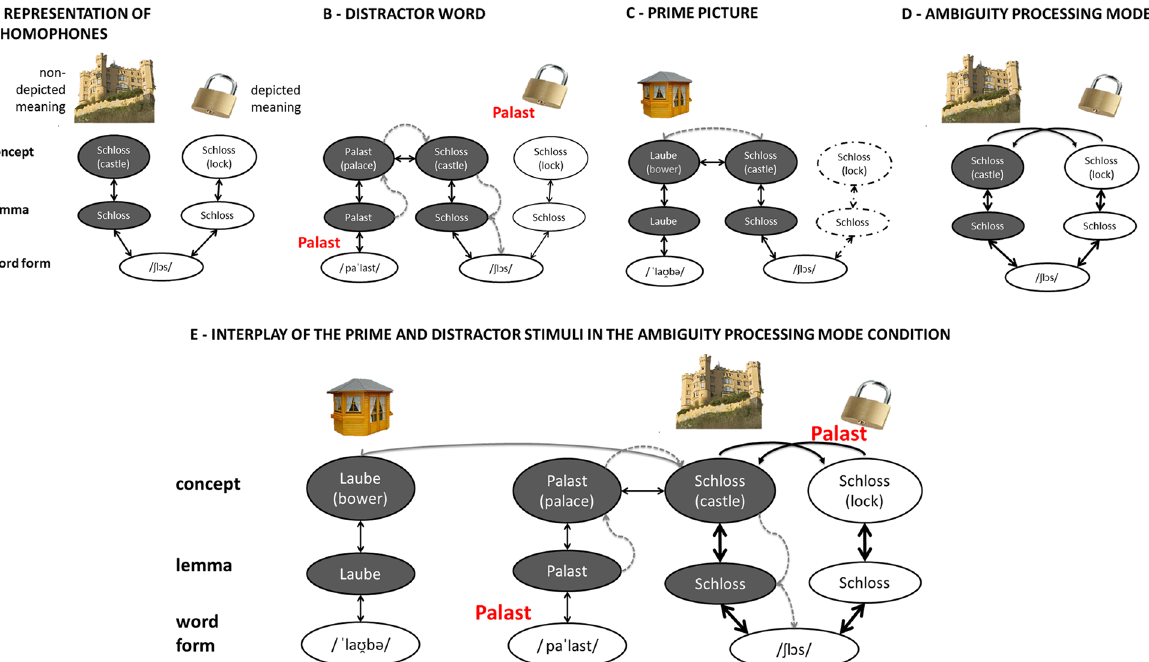
Fig 1. Models explaining effects of prime relatedness, distractor relatedness and ambiguity processing mode on naming of pictures with homophone names. (A) Representation of homophones: homophones have different conceptual and lexical representations but share the same word form. (B) Cascading information flow of distractor words related to the non-depicted meaning of the homophone and pre-activation of the shared word form. (C) Pre-activation of the non-depicted meaning by a previously presented prime stimulus that is categorically related to the non-depicted meaning of the target ‘ s name. (D) Listening to puns leads to the co-activation of both meanings of a homophone due to enhanced feedback between phonological, lexical and semantic stages and thus the ambiguity status of a target ‘ s name is quickly available. (E) Interplay of the prime and distractor stimuli in the ambiguity processing mode